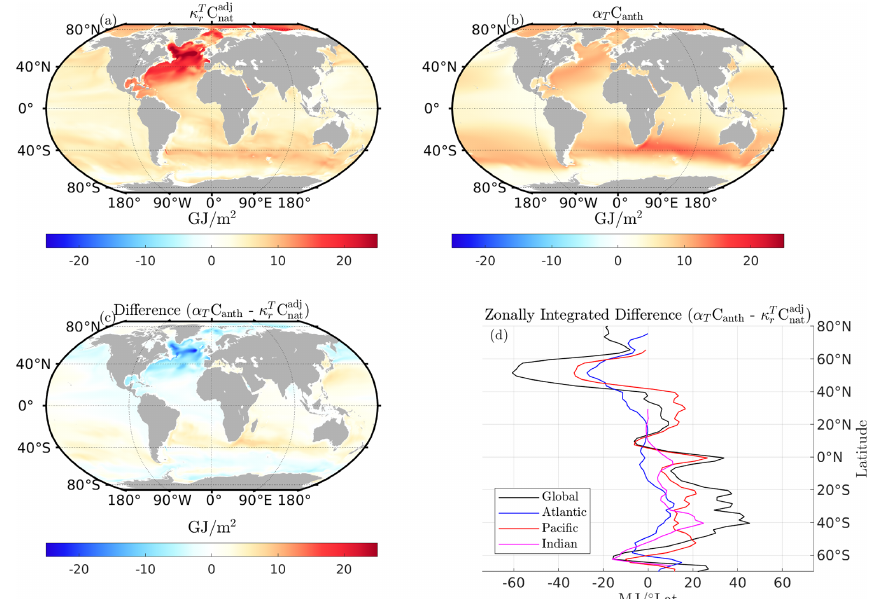
Figure 4. Column inventories of excess heat (0–2000m) calculated as the 2090–2099 decadal mean excess temperature relative to prein- dustrial. Panel (a) shows our method, panel (b) the method of Bronselaer and Zanna (2020), and panel (c) the difference between the two estimates. Panel (d) shows the zonally integrated upper 2000m excess heat content difference.